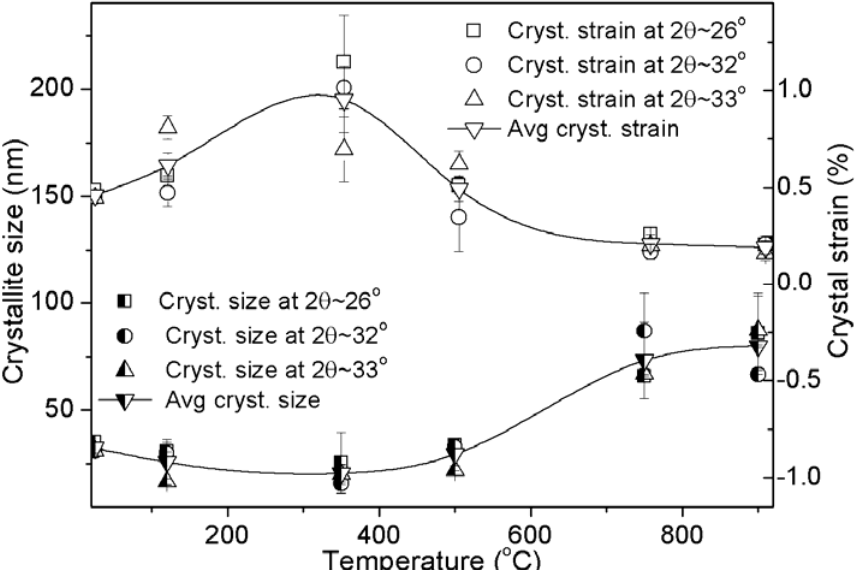
Figure 3. Crystallite size and crystal strain at different heat treated bovine bones including as-received